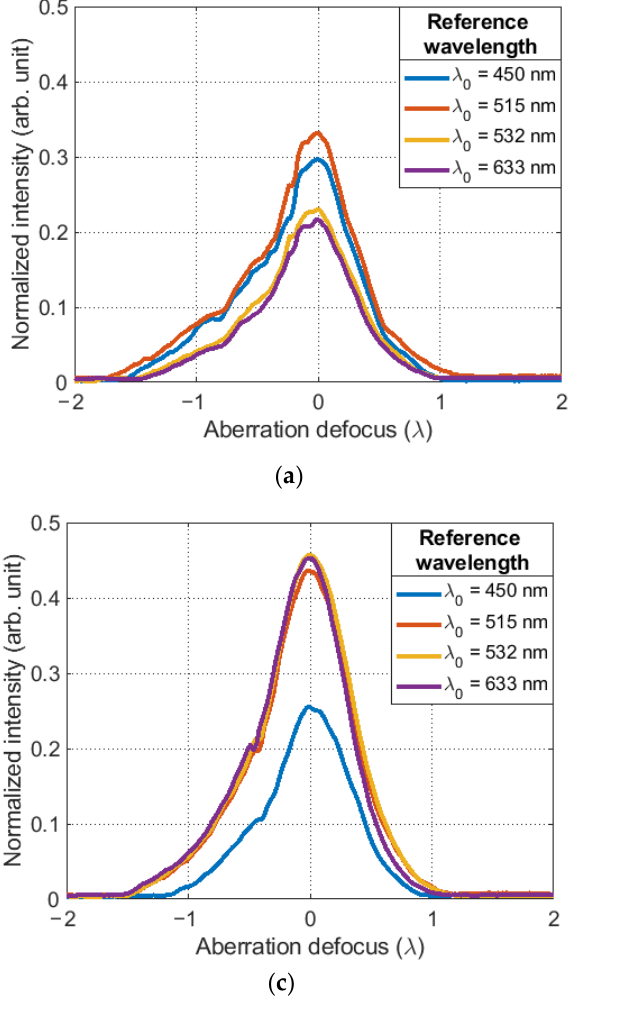
Figure 7. The normalized amplitude of the maximum of the correlation function depending on various parameters of the SLM for sources with a wavelength: ( a ) λ 1 = 473 nm; ( b ) λ 2 = 532 nm; ( c ) λ 3 = 561 nm; ( d ) dependence of maximum correlation function on SLM settings related to reference wavelength λ 0